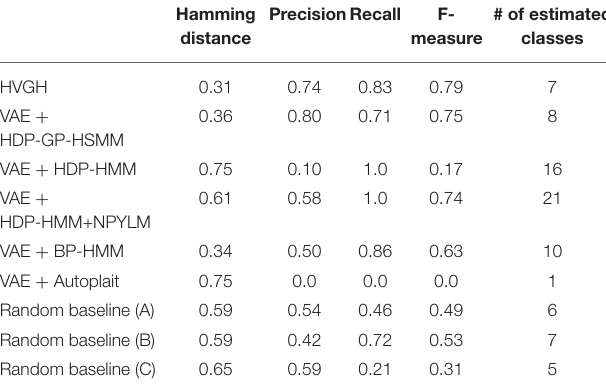
TABLE 2 | Segmentation results for the teapot dance.